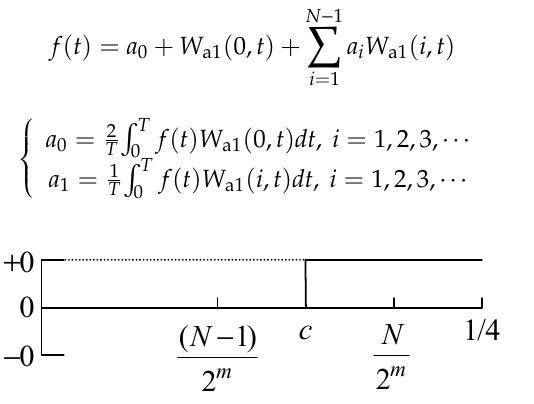
Figure 3. A quarter cycle of a normalized three-level Pulse width modulation (PWM) waveform.